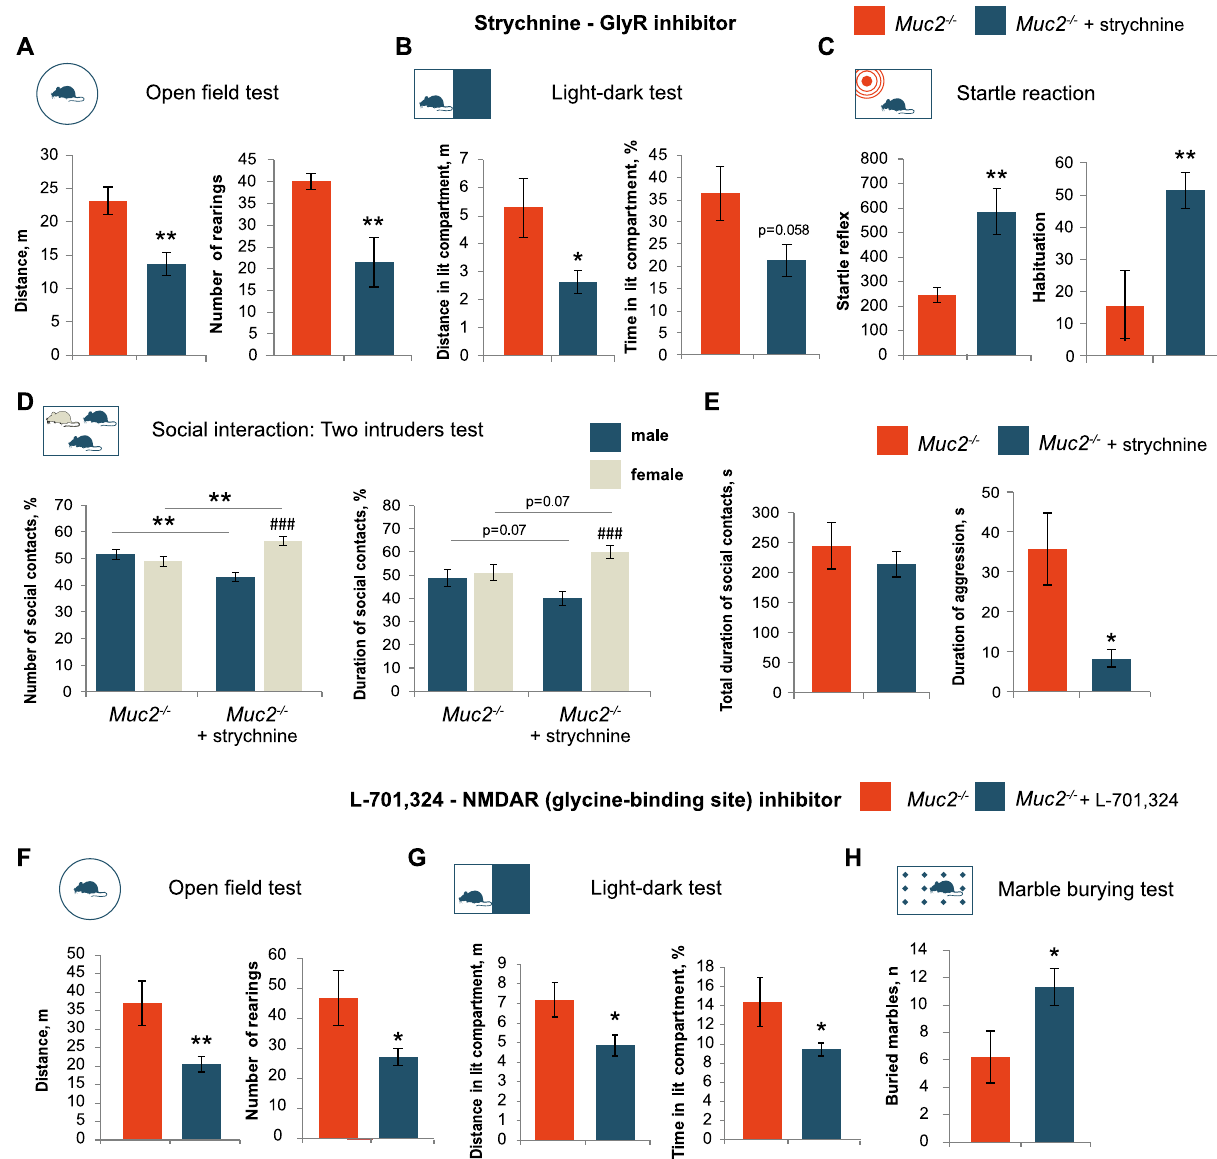
Figure 5. Glycine neurotransmission mediates behavioral abnormalities in Muc2 model of colitis. ( A ) Open field test after strychnine treatment ( n = 10–13). Distance: t = 3.53, p = 0.001; rearings: t = 2.897, p = 0.009, Student’s t -test. ( B ) Light–dark test, ( n = 7–8). Distance in light compartment: t = 2.21, p = 0.045; time in light compartment: t = 2.08, p = 0.058, Student’s t -test. ( C ) Startle reflex and habituation ( n = 10–12; startle: t = − 3.16, p = 0.005; habituation: t = − 3.09, p = 0.006, Student’s t -test). ( D ) Two intruders test ( n = 10/group). Two-way ANOVA revealed a statistically significant interaction between the treatment and the intruder gender (number of contacts: F (1, 46) = 21.39, p < 0.001; duration: F (1, 46) = 6.95, p = 0.011. Number of contacts ( Muc2 −/− + strychnine, male vs. female, p < 0.001, Fisher’s LSD test; duration ( Muc2 −/− + strychnine, male vs. female): p < 0.001, Fisher’s LSD test. Number of contacts with a male/female intruder vs. treatment, p = 0.003, Fisher’s LSD test; duration of contact with a male/female intruder vs . treatment, p = 0.07, Fisher’s LSD test. ( E ) Two intruders test ( n = 10/group). Total duration of social contacts (not significant), duration of aggression: t = 0.75, p = 0.022, Student’s t -test. ( F ) Open field test after L-701,324 treatment ( n = 5–11). Distance: t = 3.303, p = 0.005; rearings: t = 2.71, p = 0.017, Student’s t -test. ( G ) Light–dark test, ( n = 5–11). Distance in light compartment: t = 2.36, p = 0.033; time in light compartment: t = − 2.56, p = 0.023, Student’s t -test. ( H ) Marble burying test (n = 9/per group, Z = − 1.99, p = 0.047; Mann–Whitney u test). * = p < 0.05, *** = p < 0.001 vs . C57BL/6. ### = p < 0.001, male vs . the gut-brain crosstalk. There are a number of potent ways for choline to affect CNS function, including up- regulation of the brain acetylcholine 65,66 . We have not investigated this neurotransmitter and its effects here as elevated pre-synaptic choline was shown to impair spontaneous alternations in Y-maze and reduce time in open arms in elevated plus-maze 67 , which is not consistent with our behavioral phenotyping. Moreover, we did not